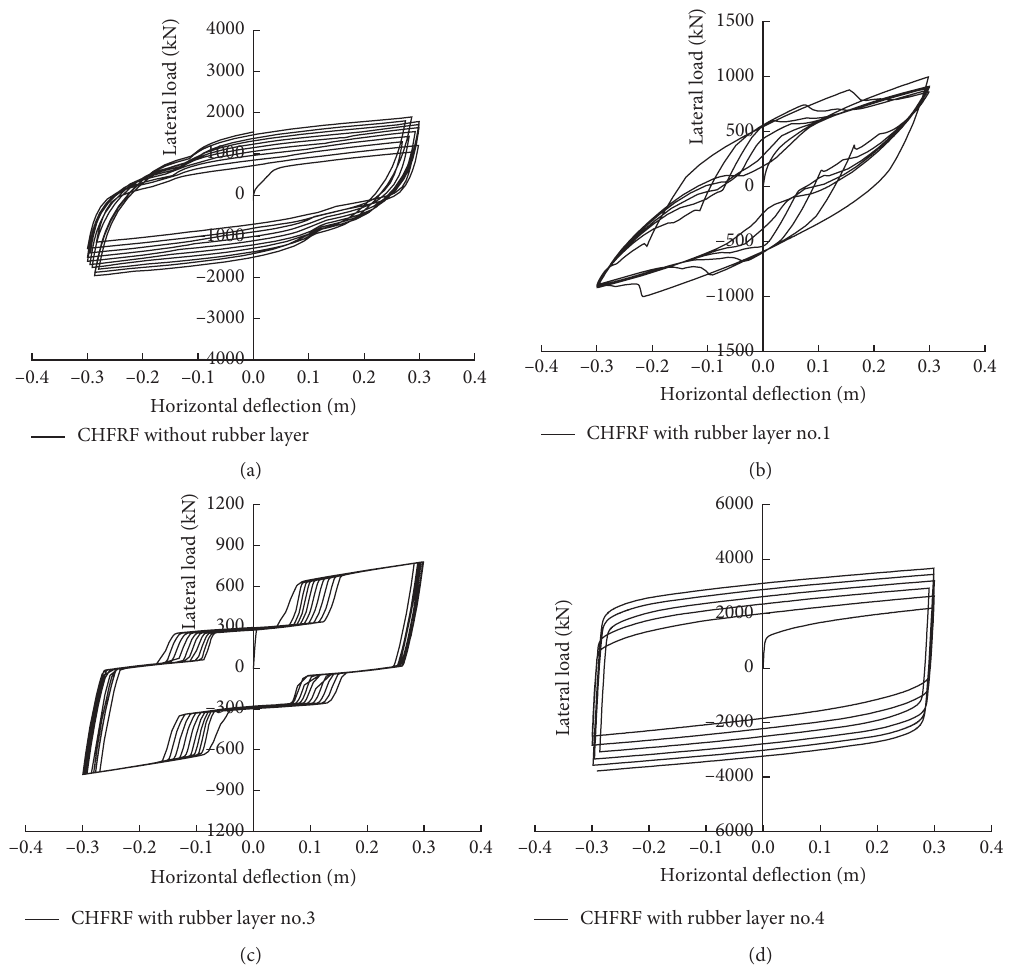
Figure 19: Effects of rubber layer on the lateral bearing capacity. (a) CHFRF without rubber layer. (b) CHFRF with rubber layer no.1. (c) CHFRF with rubber layer no.3. (d) CHFRF with rubber layer